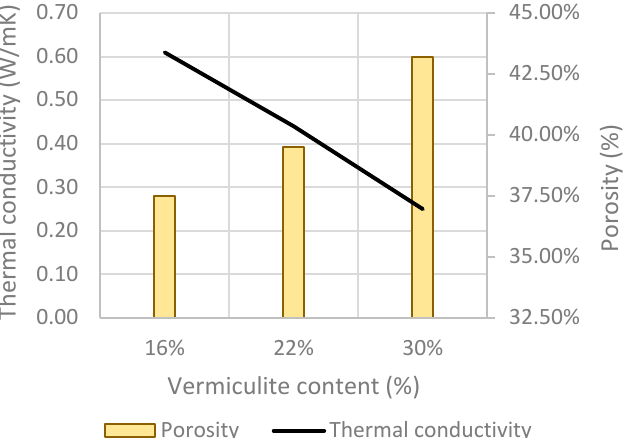
Figure 13. Correlation between thermal conductivity and porosity from the study by Palomar et al. (2015) [44].